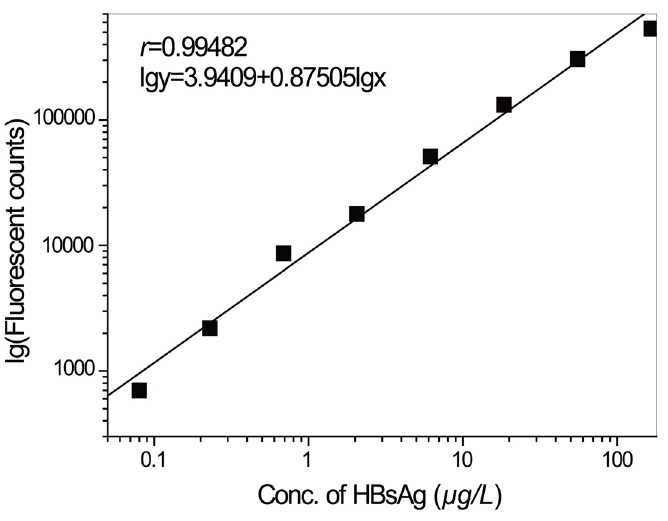
Fig 10. Calibration curves for